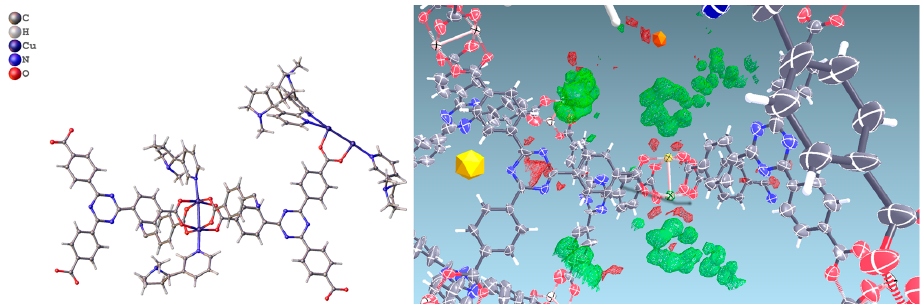
Figure 3. ( Left ) Asymmetric unit of the structure of PCN-6@nicotine, showing four guests coordinated to the copper atoms of the paddlewheel SBU; one guest is disordered on two positions; ( Right ) Difference Fourier map (drawn at the 2.5 sigma level) showing the electron density of two ordered coordinated guests.